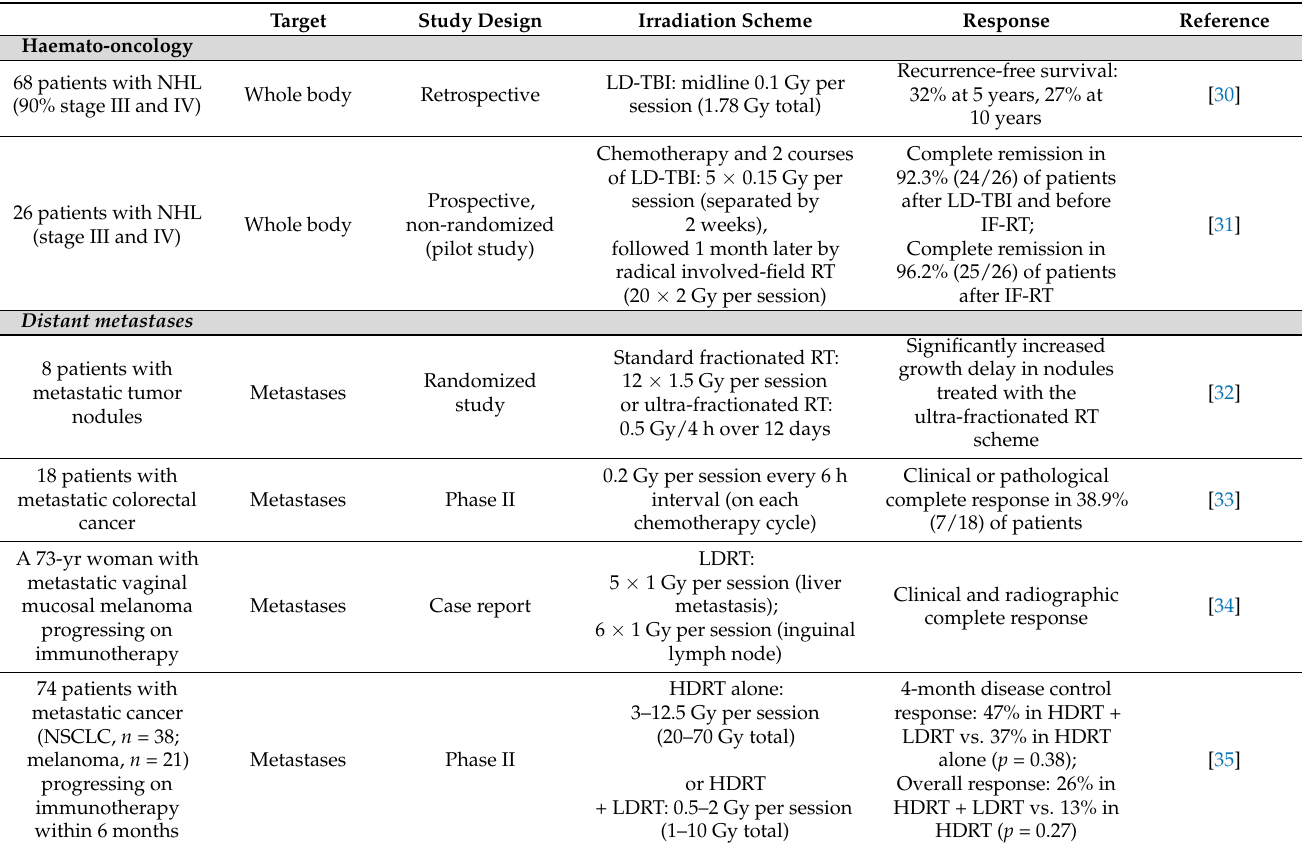
Table 1. State of the art of low-dose radiation therapy (LDRT) in